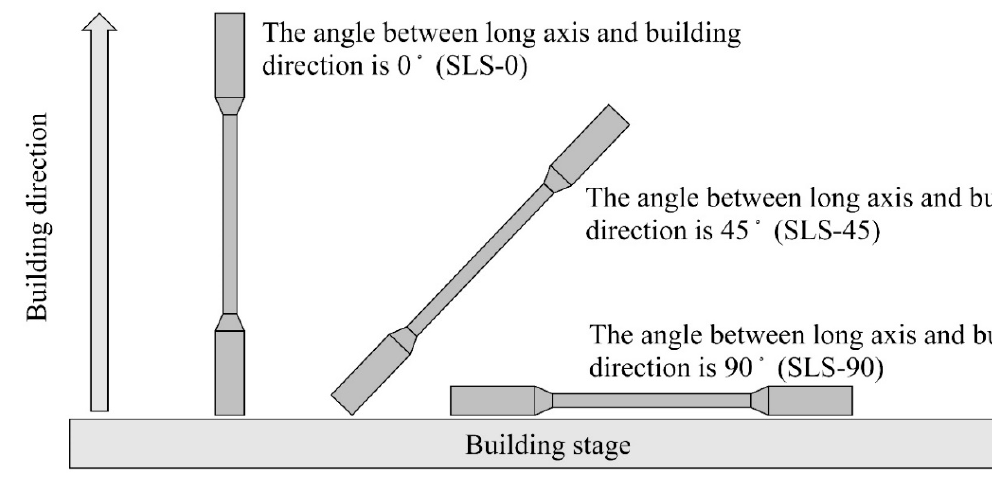
Figure 1. Building direction of SLS specimens.